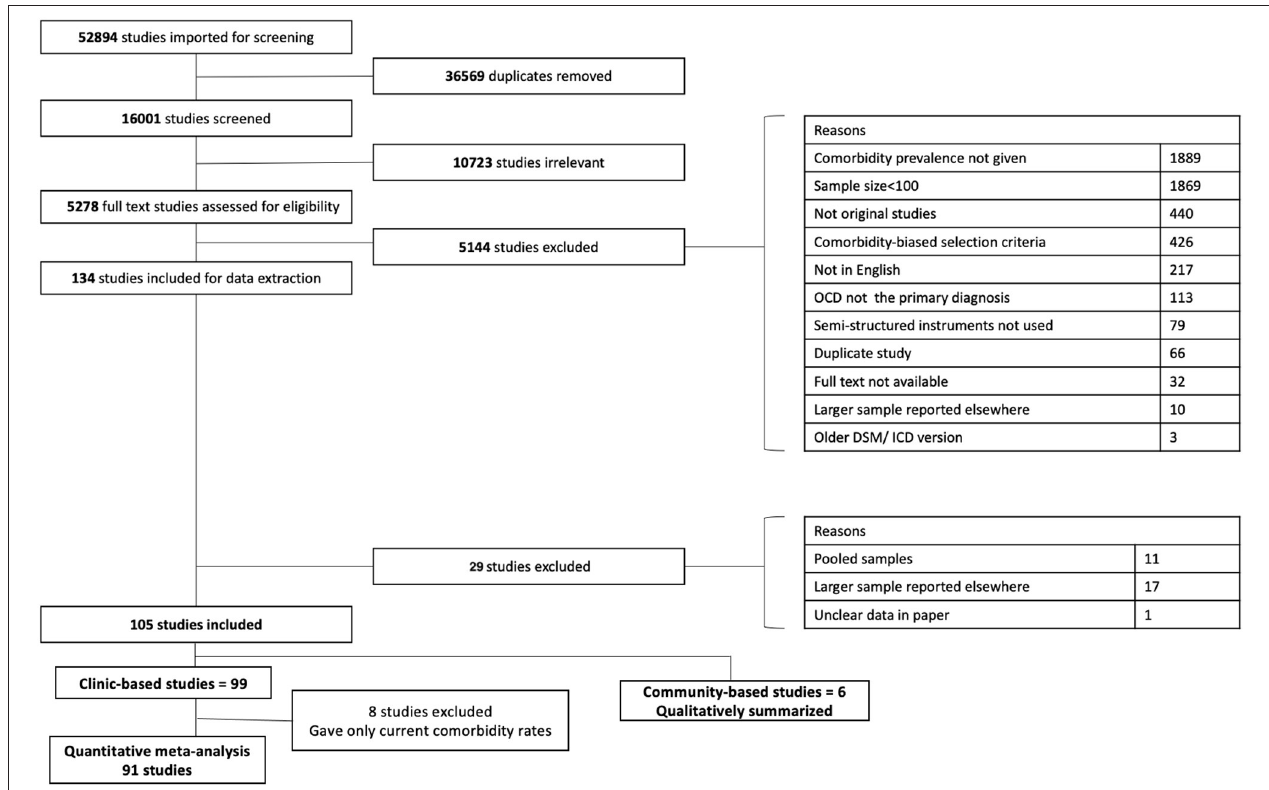
FIGURE 1 | PRISMA flow diagram.